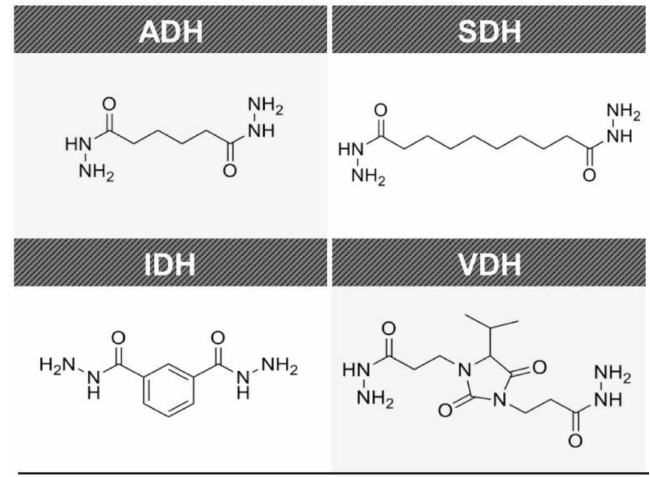
Figure 1. Chemical structures of ADH, IDH, SDH, and